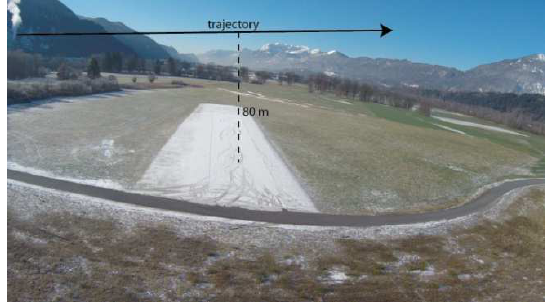
Figure 4. Flat terrain test case at model